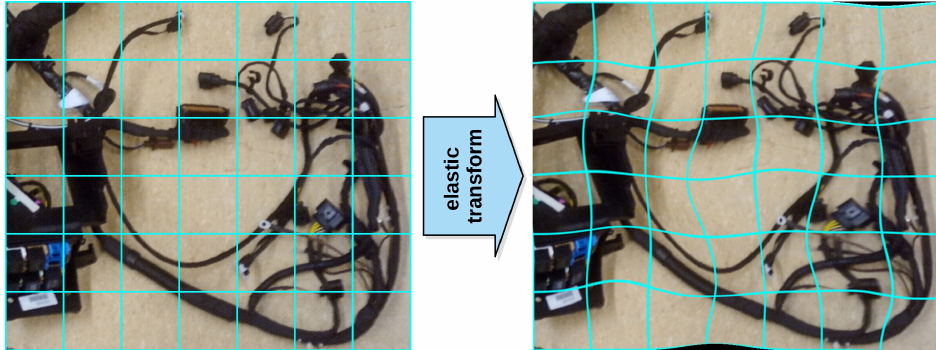
Figure 4. Sample effect of the elastic transform ( right ) on an example image ( left ). A blue grid is superimposed on the image to better illustrate the effect the transform has on the input